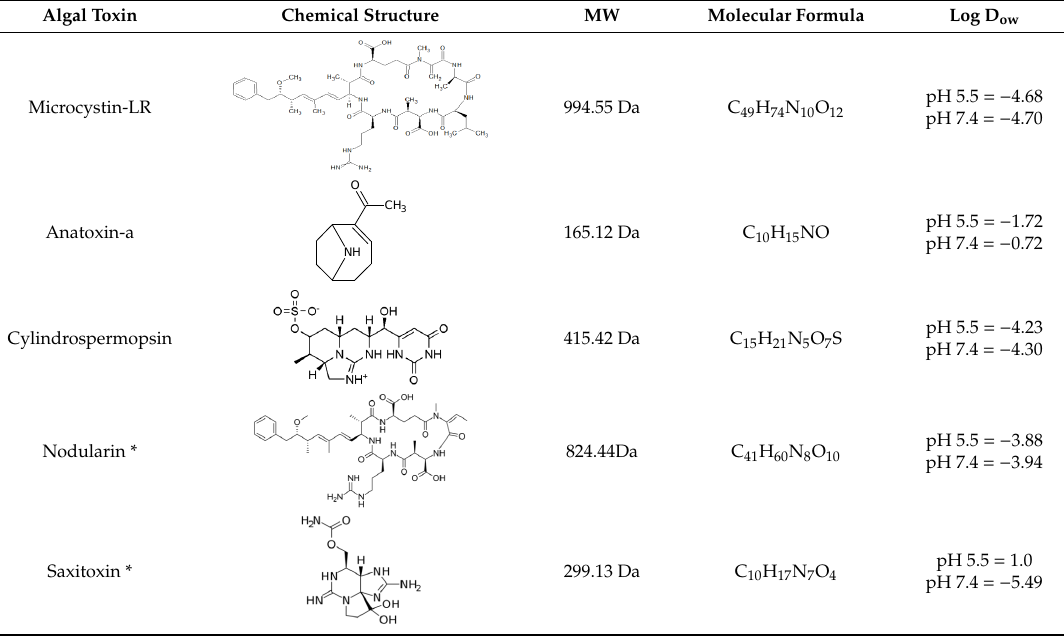
Table 1. Physico/chemical properties of several algal toxins.